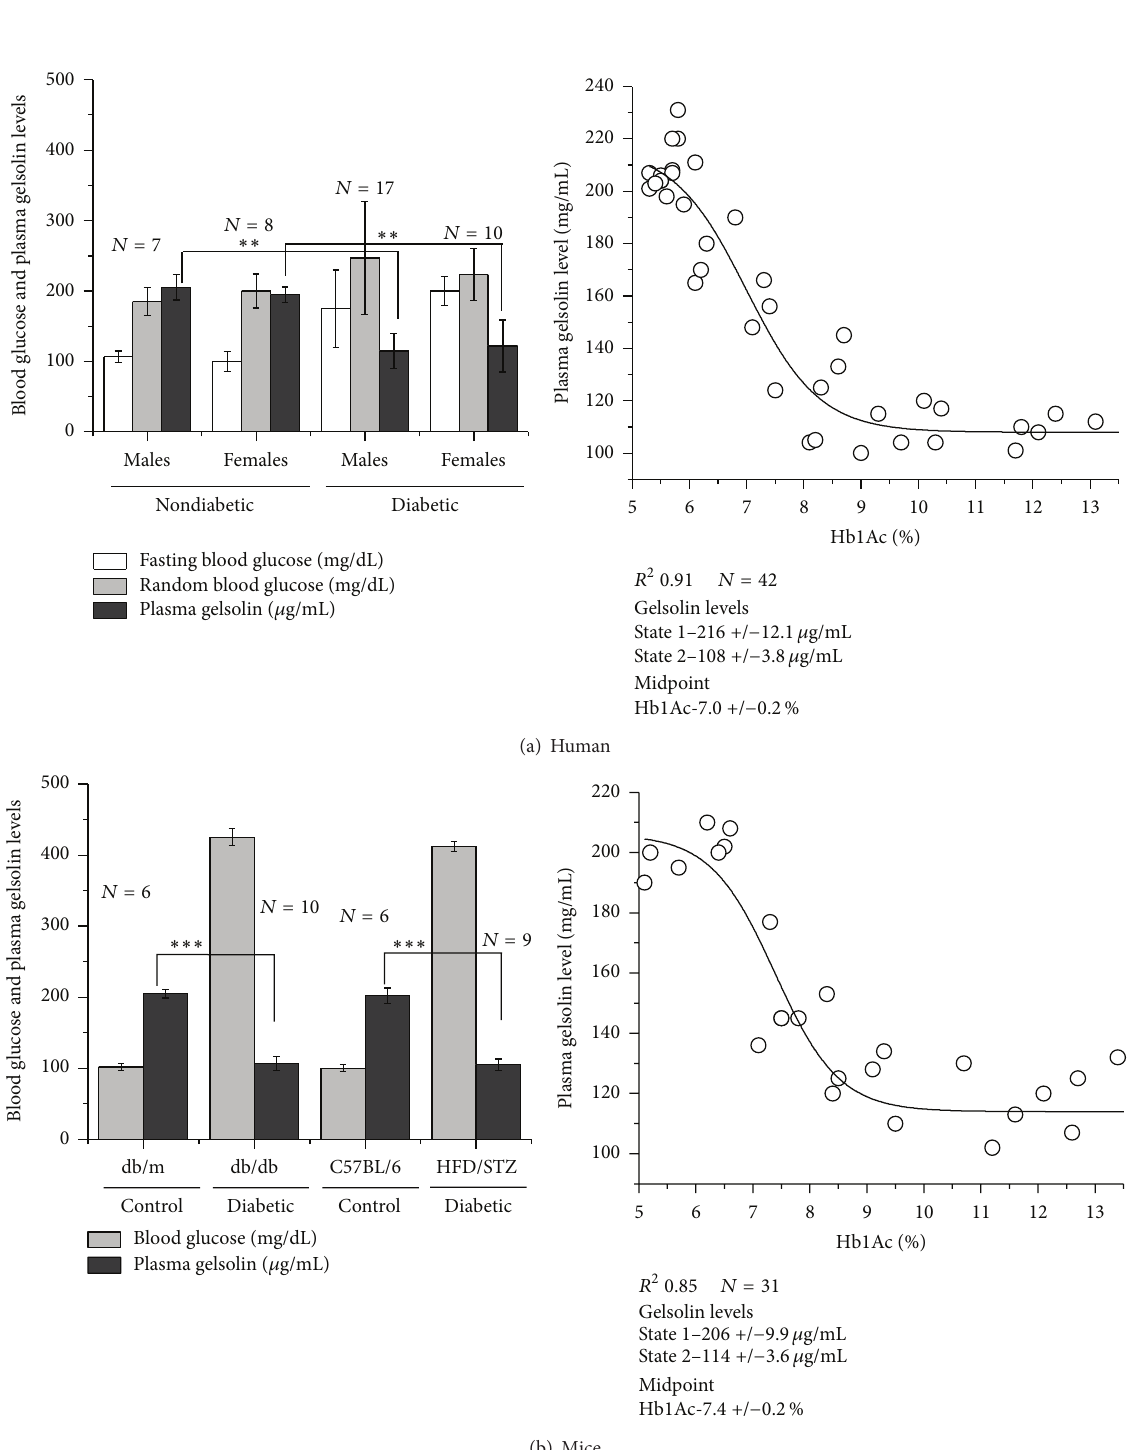
Figure 1: Blood glucose and plasma gelsolin (pGSN) levels in nondiabetic and diabetic human volunteers (a) and mice (b) have been plotted here. The right panels show the correlation between the pGSN values and glycated hemoglobin (HbA1c) percentages in the blood samples. Insetboxesshowtheparametersobtaineduponsigmoidalfit.Theresultsareexpressedasmean ± S.E.M. 𝑃 valuesareasmentionedinMethods (Section